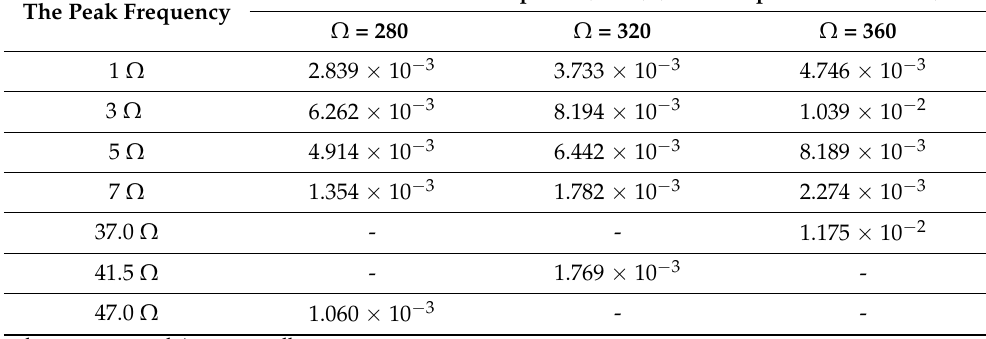
Table 4. The peak amplitude of the lateral vibration spectrum of the follower output node D at three rotation speeds. The Peak